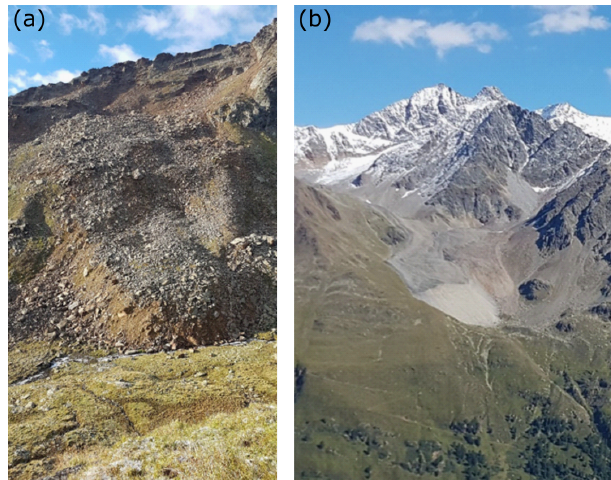
Figure 2. Images of two of the studied rock glaciers. (a) The north- exposed rock glacier RG08, located at the entrance to the Krum- mgampen valley and covering an area of 0.088km 2 . (b) The well- studied, west-exposed Ölgruben rock glacier RG01 covering an area of 0.237km 2